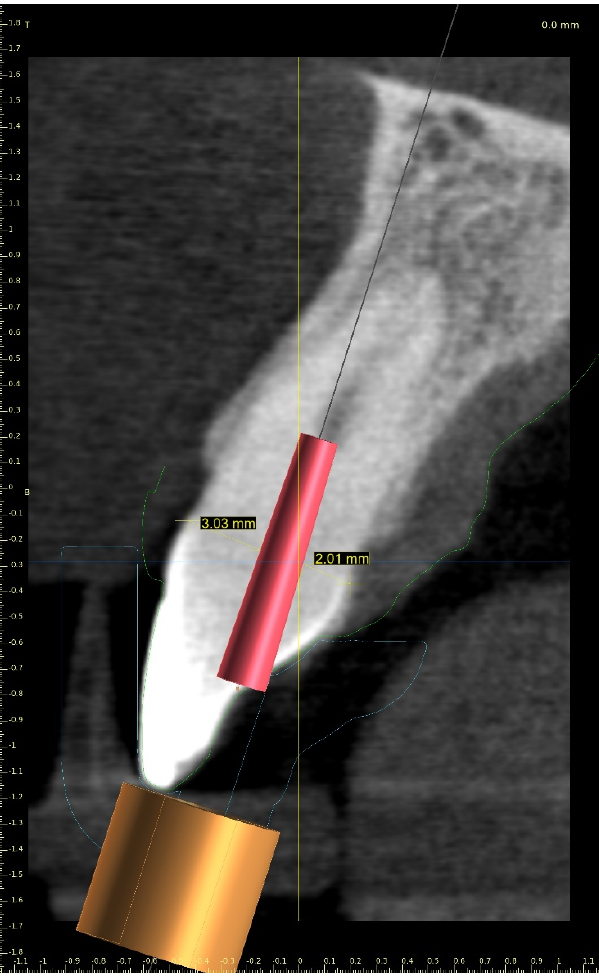
Figure 2. CBCT image showing visible part of root canal. Custom virtual implant was placed according to access path preserving the minimum thickness of the dentine.